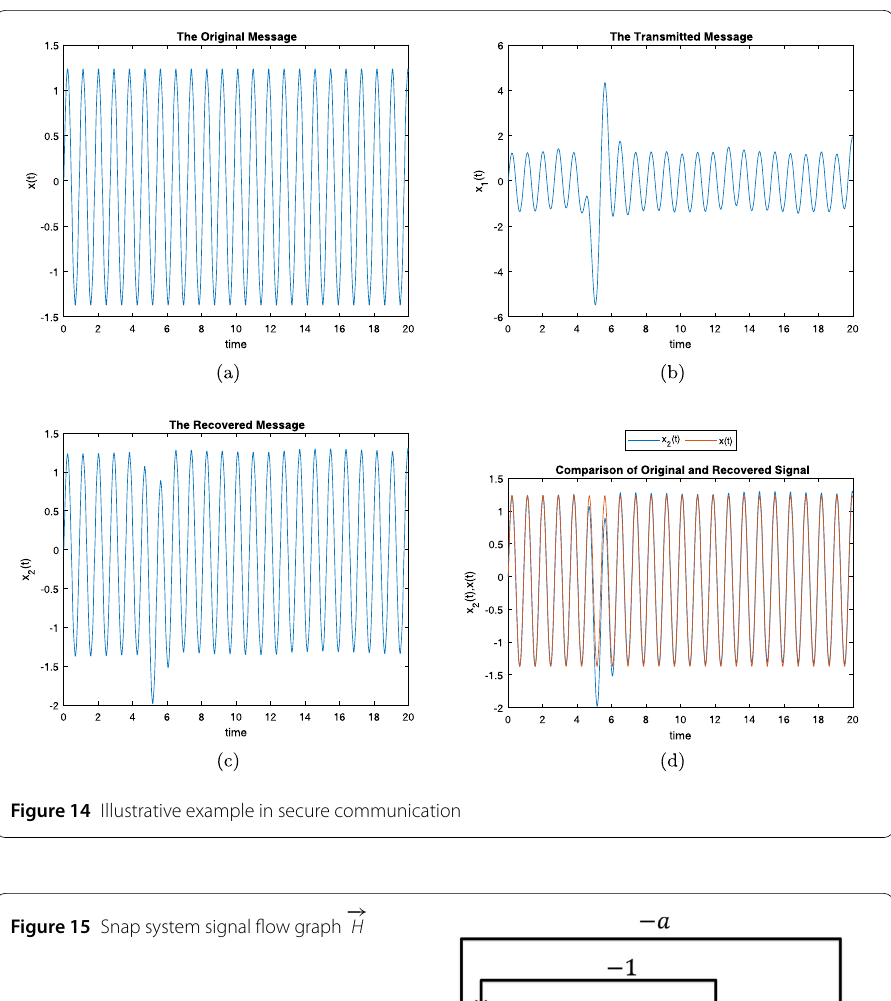
Figure 15 Snap system signal flow graph